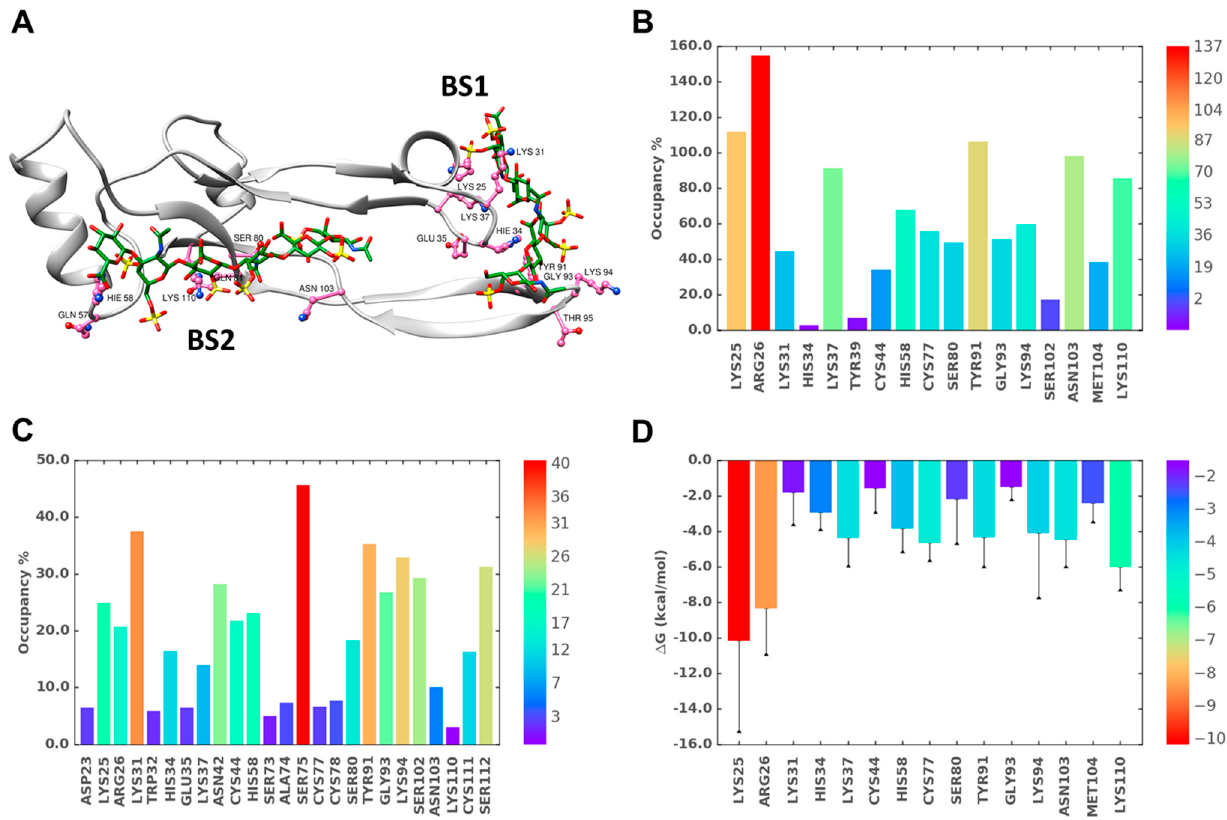
Figure 9. MD simulation of the TGF- β 2–CS06 complex when engaged at both sites of binding, BS1 and BS2. ( A ) A representative structure from the MD trajectory showing the hydrogen bonds (H-bonds) between TGF- β 2 residues (hot pink; ball and stick representation) and CS06 (green sticks). The protein ribbon is shown in light grey. ( B ) Inter-molecular H-bond formation in terms of % occupancy (proportion of MD frames showing direct H-bonds) for residues of BS1 and BS2. ( C ) Proportion of water-mediated H-bonds (i.e., occupancy) between TGF- β 2 for residues in BS1 and BS2 and CS06. ( D ) Single-residue energy decomposition (SRED) values for the TGF- β 2–CS06 complex for residues of BS1 and BS2. Error bars show standard deviation. For ease of interpretation, values from lower to higher are represented by rainbow color (blue → red).